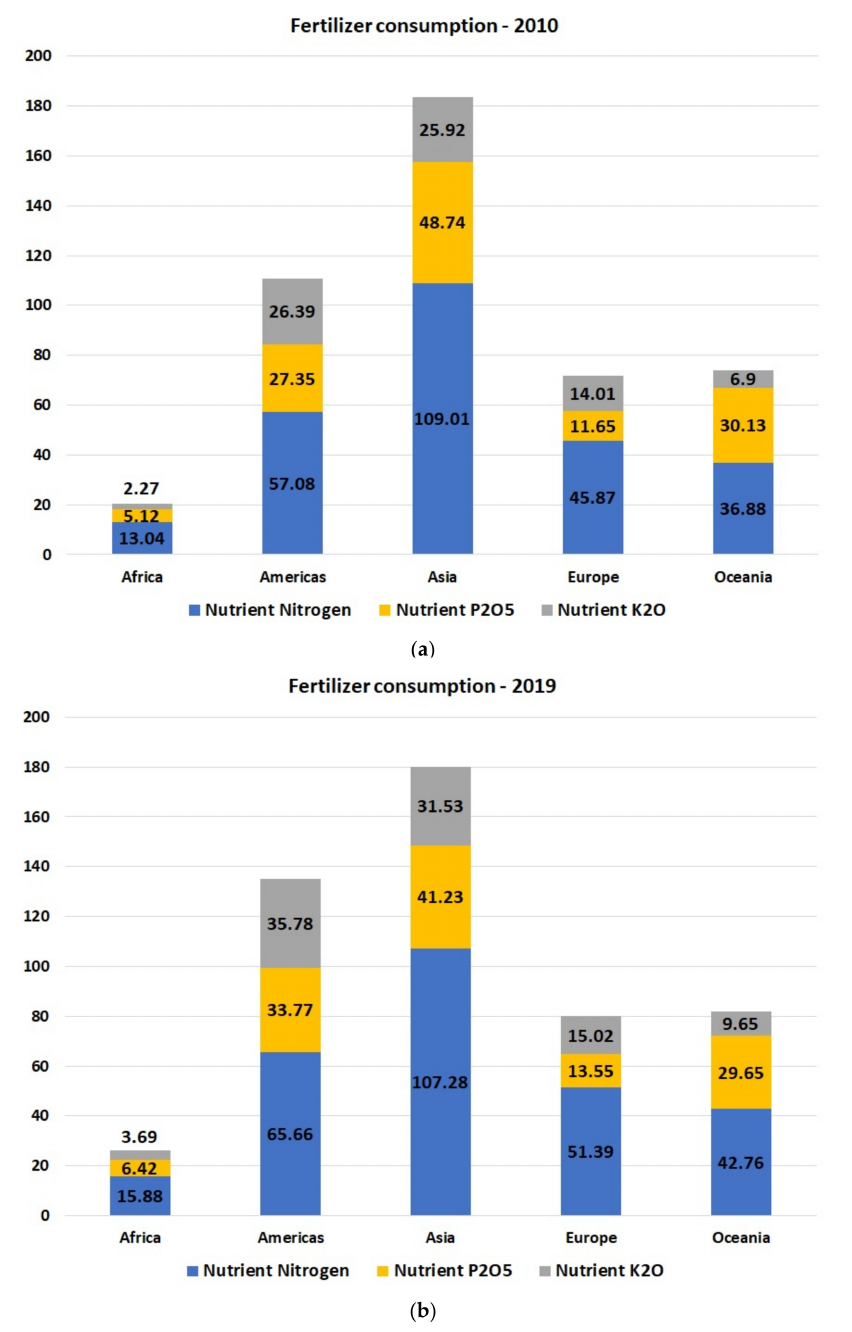
Figure 1. Fertilizer consumption expressed as nitrogen, phosphate, P 2 O 5 , potassium K 2 O, in the last 10 years ( a ) 2010, ( b ) 2019